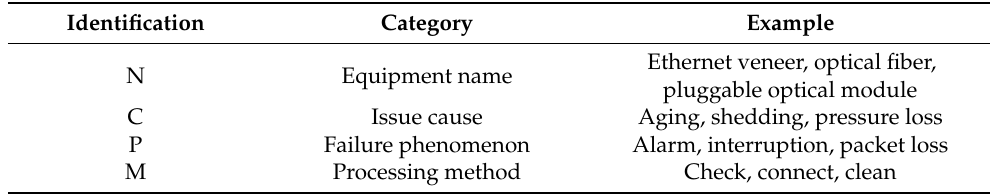
Table 2. Fault Entity Corpus Tagging.